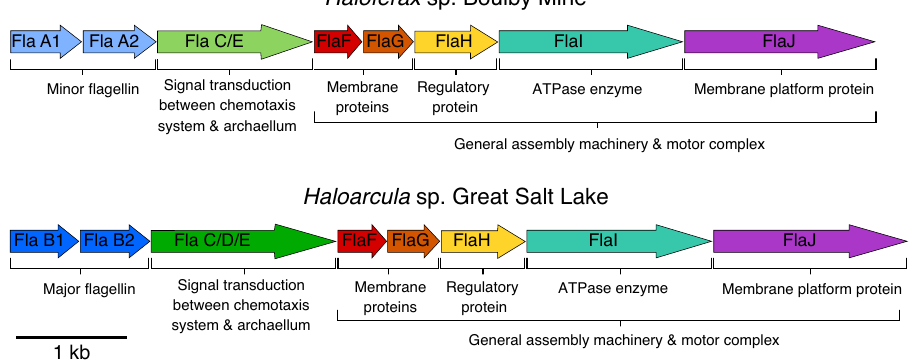
Fig. 1 Motility gene organisation. Organisation of the fl a operons in our environmental isolates Haloferax sp. Boulby Mine (HXBM) and Haloarcula sp. Great Salt Lake (HGSL) showing fl agellins, signal transduction and motor complex components.